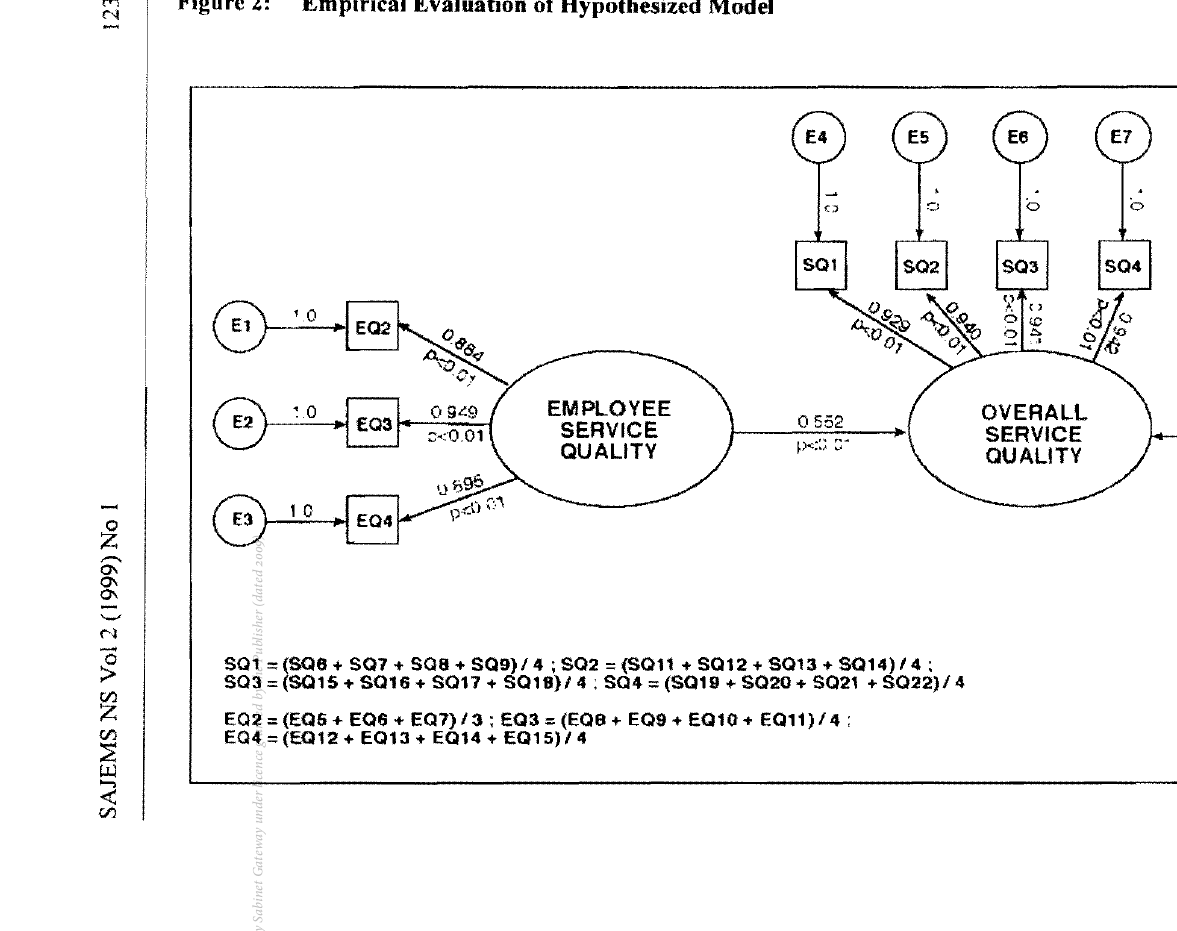
Figure 2: Empirical Evaluation of Hypothesized